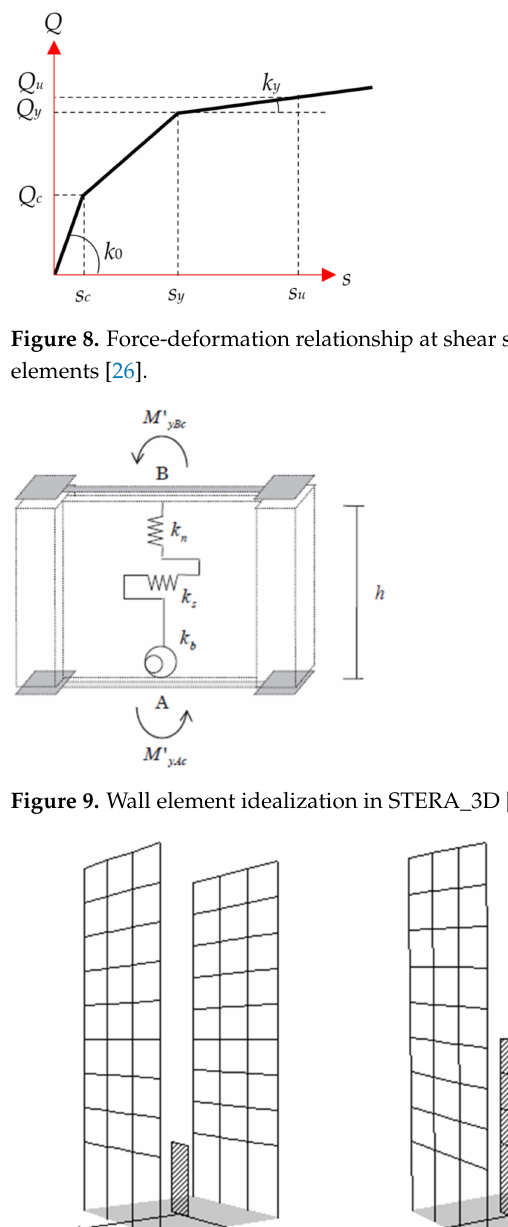
Figure 7. Moment-rotation relationship at bending spring for nonlinearity consideration in structural elements [26].